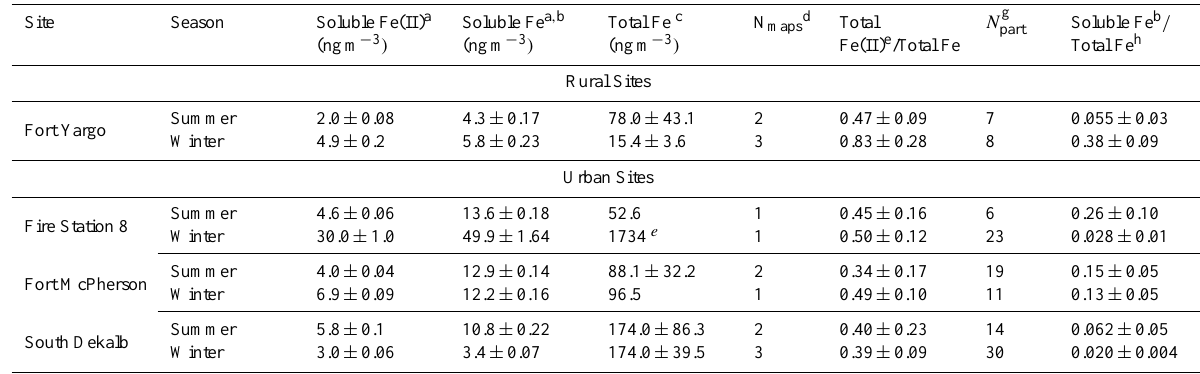
Table 2. Solubility Results for Urban and Rural Filters.